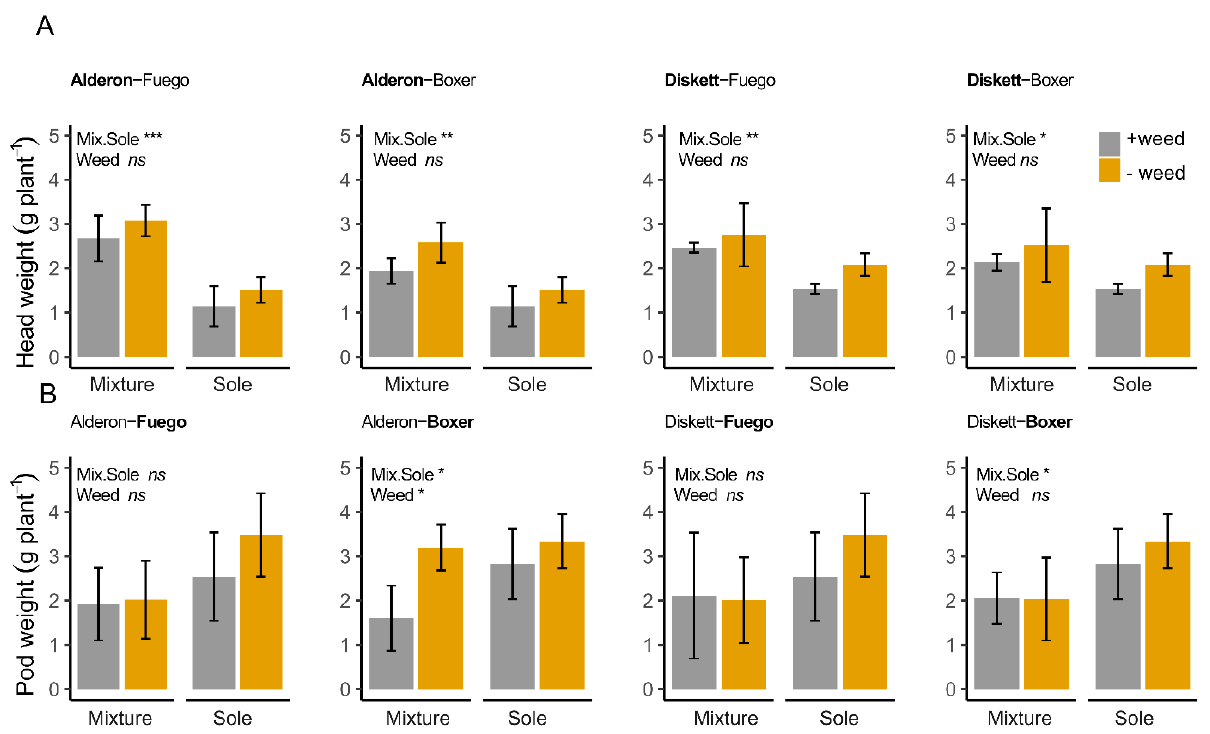
Figure 5. The mean ( A ) head height for wheat and ( B ) pod weight for two faba bean cultivars pot-grown as sole crops and in mixture, with and without the weed C. album at maturity. The error bars represent ± 1 SD of the different cultivar combinations. The cultivars whose names appear in bold correspond to the ones presented in the graph. Symbols show ANOVA results with significance levels: *** = p ≤ 0.001; ** = p ≤ 0.01; * = p ≤ 0.05; and ns= non-significant. Table 3. Pairwise comparison of scaling exponents following analysis of variance for cereals and legumes grown as sole crops and mixtures, with and without the C. album weed. The scaling exponents were based on data from the flowering stage. Symbols show results with significant